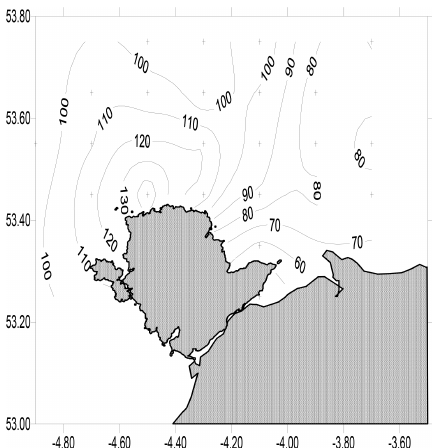
Figure 4. Amplitude of the current speed (cms − 1 ) in the study area on a mean tide. The amplitude shown is the vector sum of the east– west and north–south amplitudes. The crosses show the centres of the boxes used for drawing the contours. Figure 5. Current phase expressed as the time in minutes of the turn